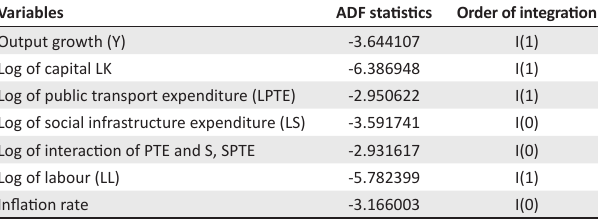
TABLE 5: Autoregressive distribution lag short- and long-run results for Mangaung. Variable: Co- integrating form